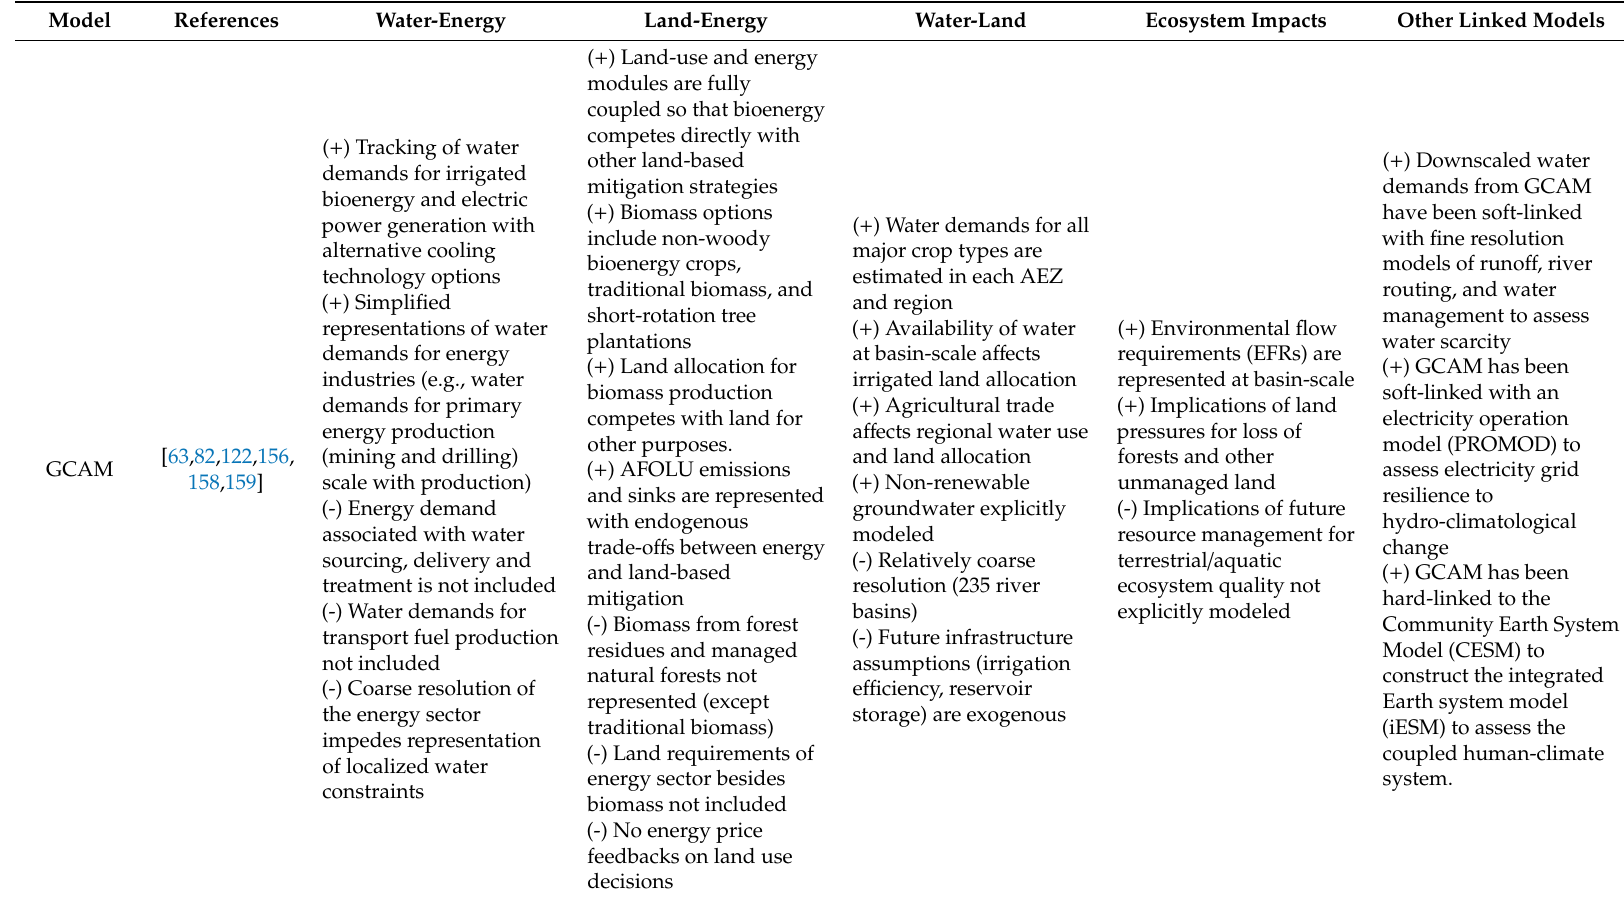
Table 1. Representation of nexus linkages within the five global economic models that were used to quantify the Shared Socioeconomic (SSP) marker scenarios [15]. ( + ) indicates aspects of each linkage that are represented in the model; (-) indicates aspects that are missing or poorly represented.